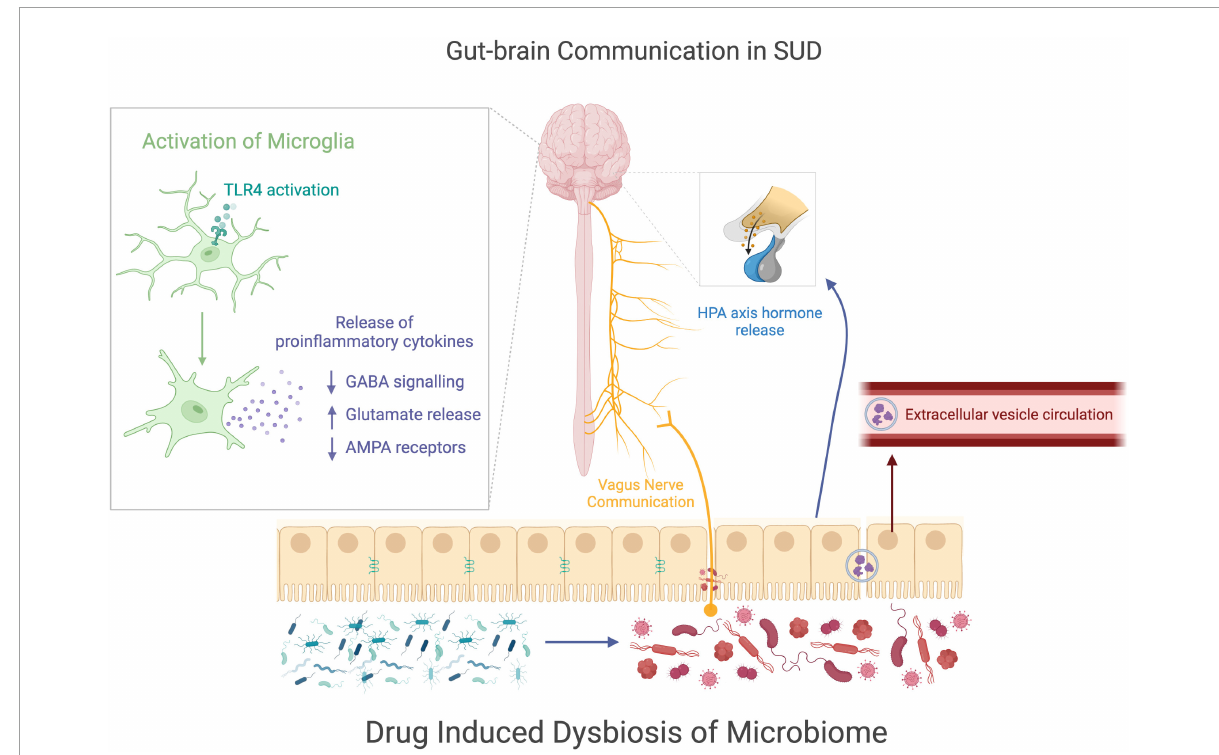
FIGURE3 Gut-brain communication in SUDs. This figure visually summarizes how drug induced changes to the microbiome may be related to cellular changes in the brain during drug use. Drug use causes a disruption of gut homeostasis, resulting in a dysbiotic state of the microbiome. The microbial change in the gut may alter the communications sent from the gut to the nervous system through the vagus nerve, the HPA axis, or extracellular vesicles. The communication between the gut and the nervous system may contribute to the increase of microglial activation, which alters astrocyte and neuron signaling, potentially modifying behaviors comorbid with drug